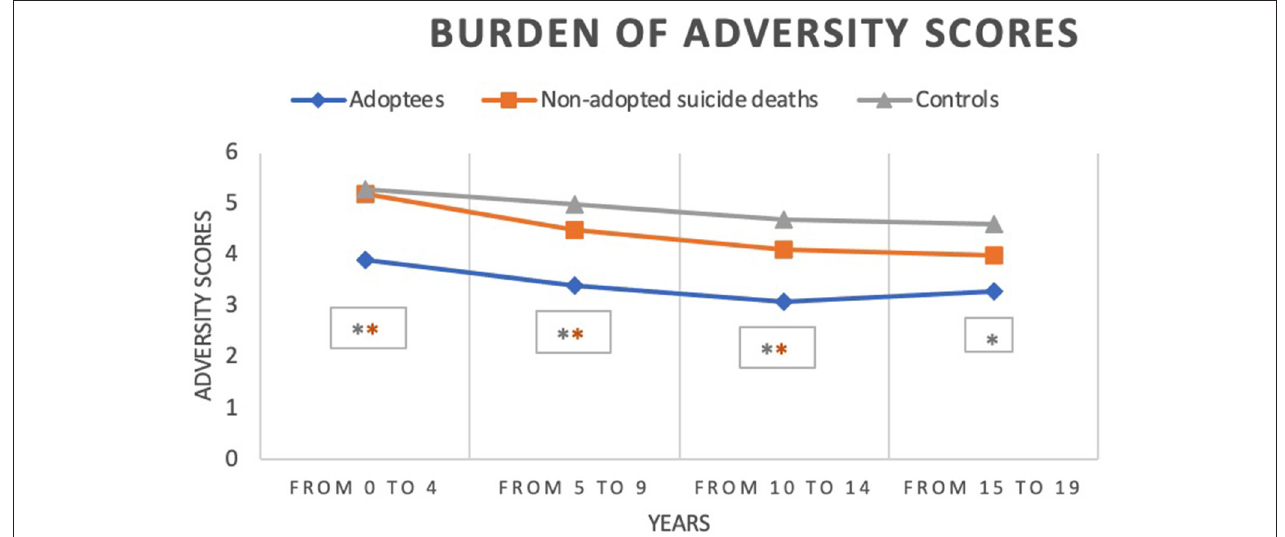
FIGURE 1 | Burden of adversity scores comparing adopted and non-adopted individuals deceased by suicide, and non-adopted living control individuals ( n = 65). *p < 0.05. The orange line compares adopted and non-adopted individuals deceased by suicide, and the silver line compares adopted and control individuals. The lower the score number, the higher the burden of